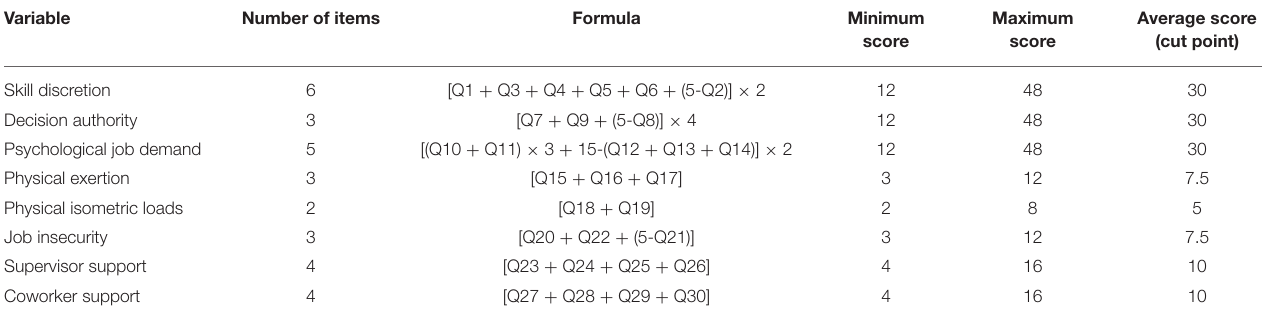
TABLE 1 | Guidance content questionnaire guide.